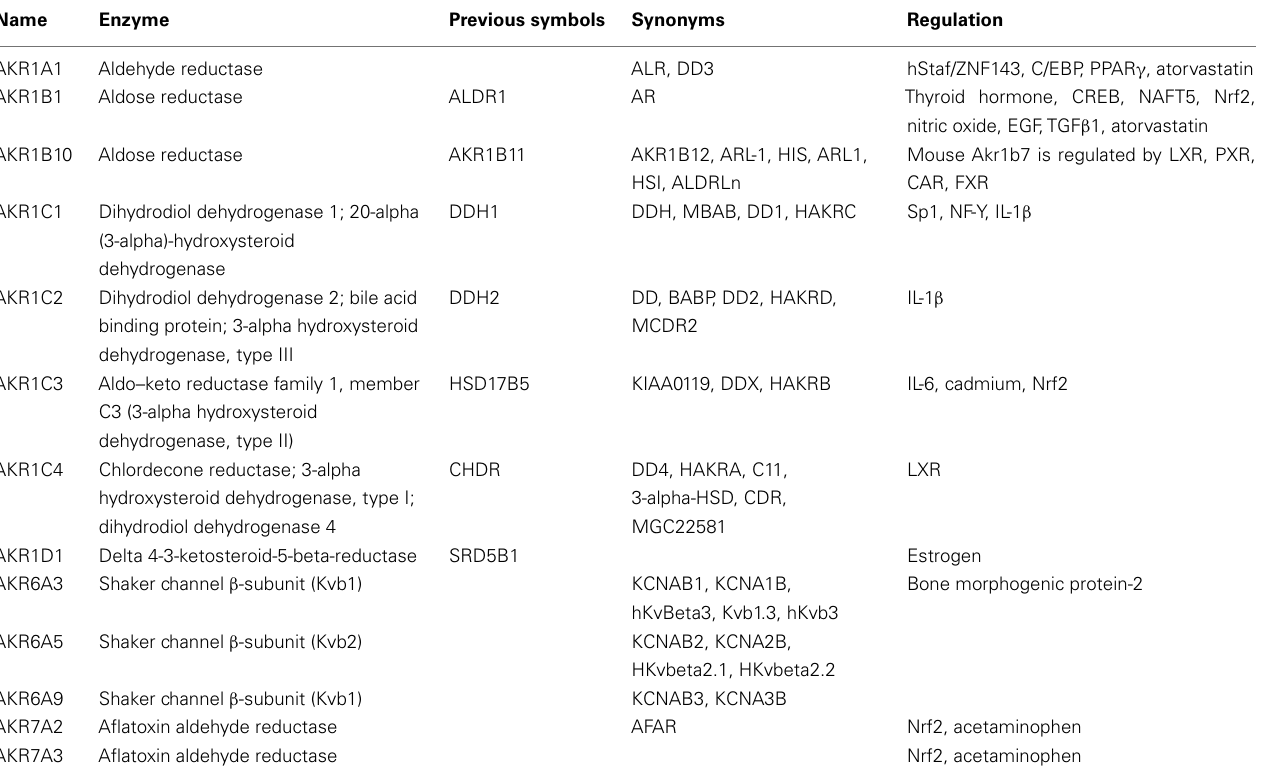
Table 1 | Regulation of human aldo–keto